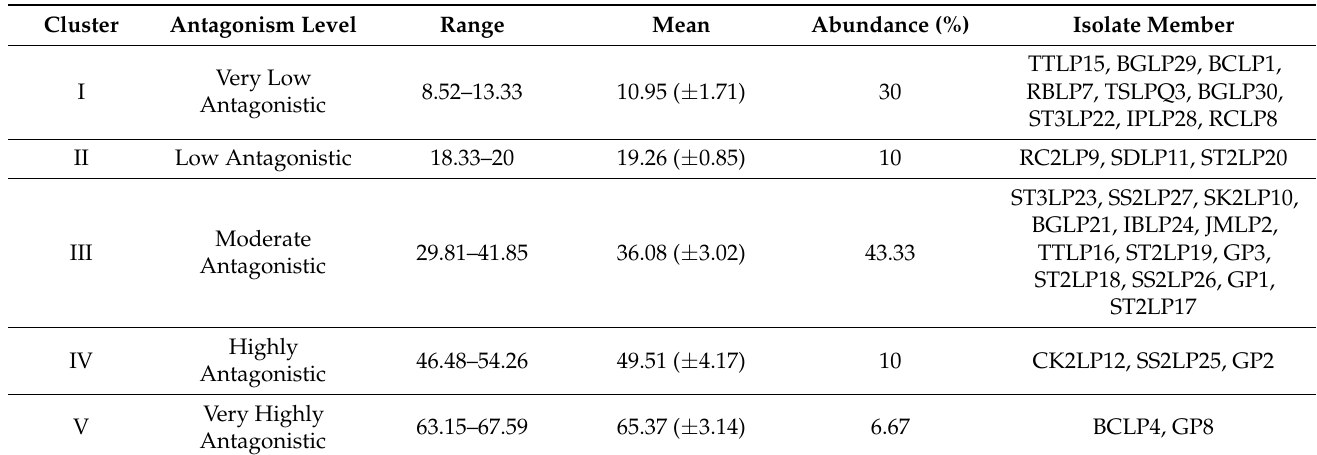
Table 3. Distribution of average antagonistic activity of Pseudomonads and associated isolates of the lateritic area of West